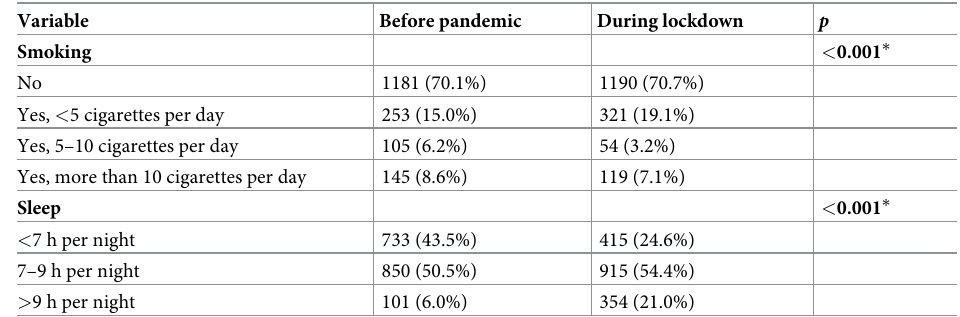
Table 4. Changes in smoking and sleep habits during the lockdown compared to before it. Variable Before pandemic During lockdown